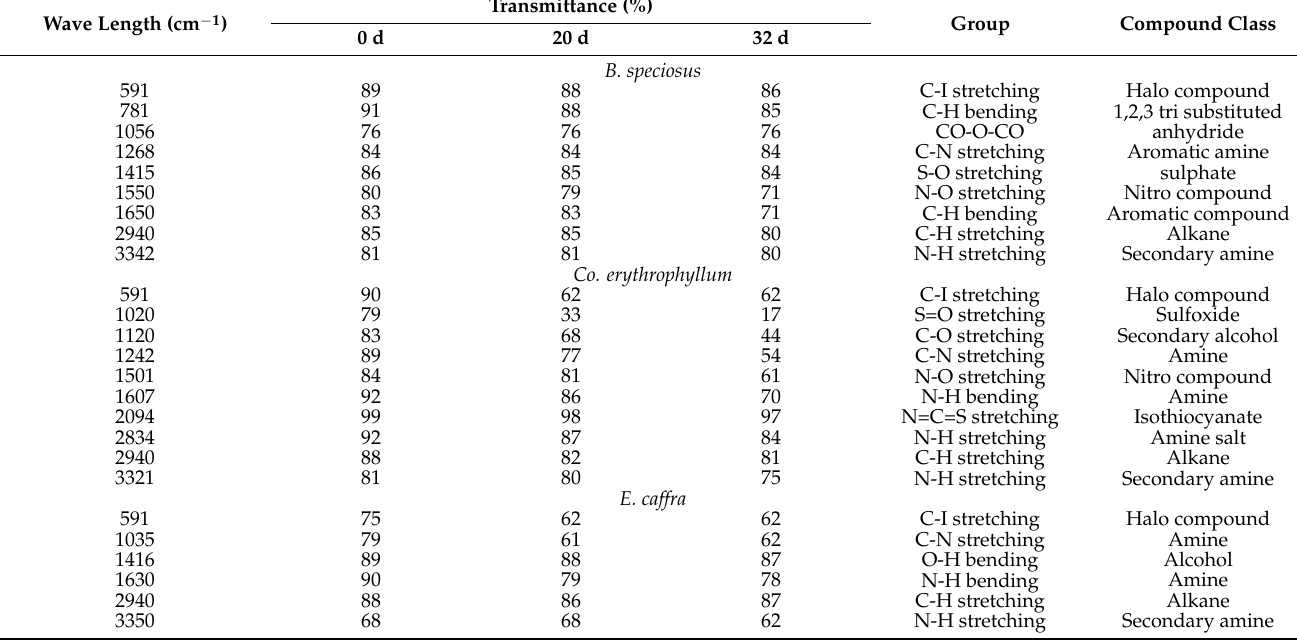
Table 2. FTIR table including the compounds present in Bolusanthus speciosus , Combretum erythrophyllum , and Erythrina caffra at 0 (control), 20, and 32 d of controlled